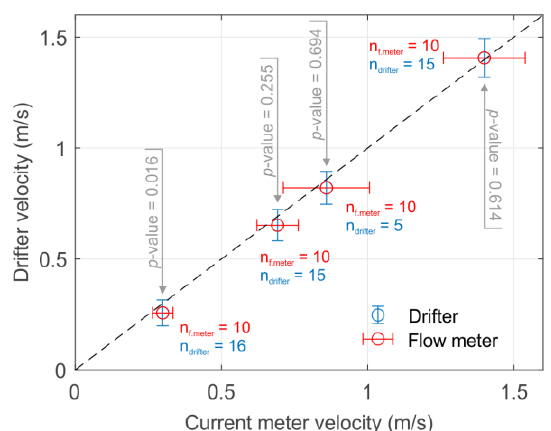
Figure 5. Comparison of the velocity estimated by a current meter and the drifter. Only for the lowest velocity a significant difference in the measurements is observed.